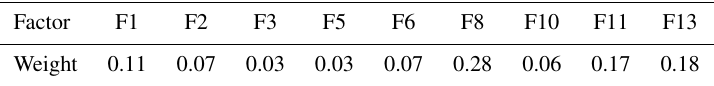
Table 12. The weighted values of the factors obtained by AHP.